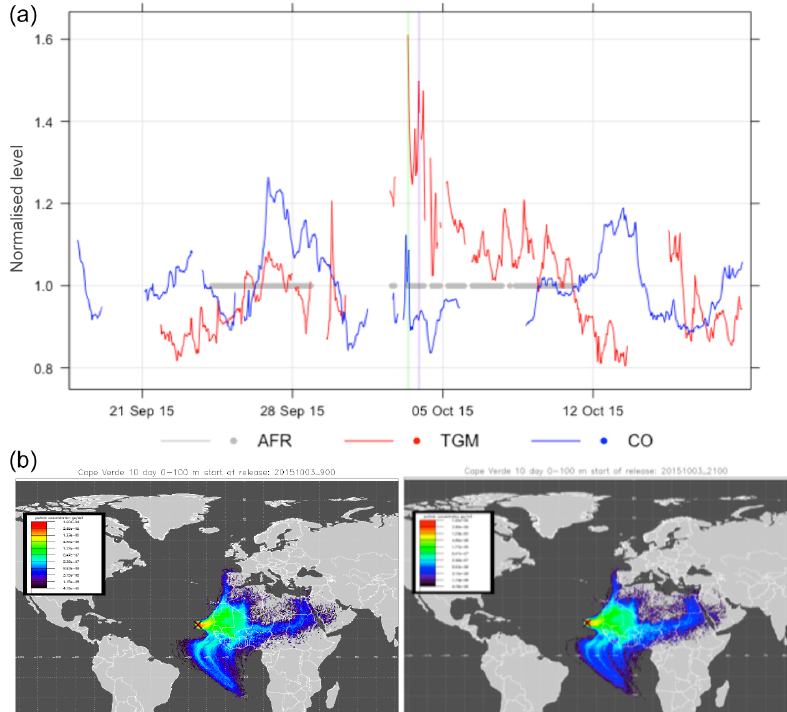
Figure 9. (a) Time series of TGM and CO. The plot is normalised by dividing by the compounds mean value, and the grey dots indicate when the air was characterised as AFR. The shaded periods correspond to the 10-day back trajectories in (b) : left, 3 October 2015, 09:00; right, 3 October 2015,